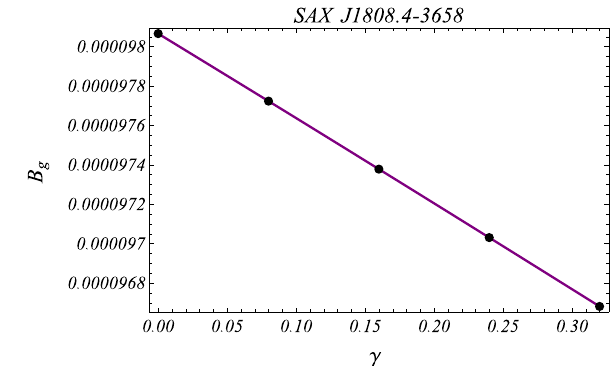
Fig. 10 The variation of B g with respect to